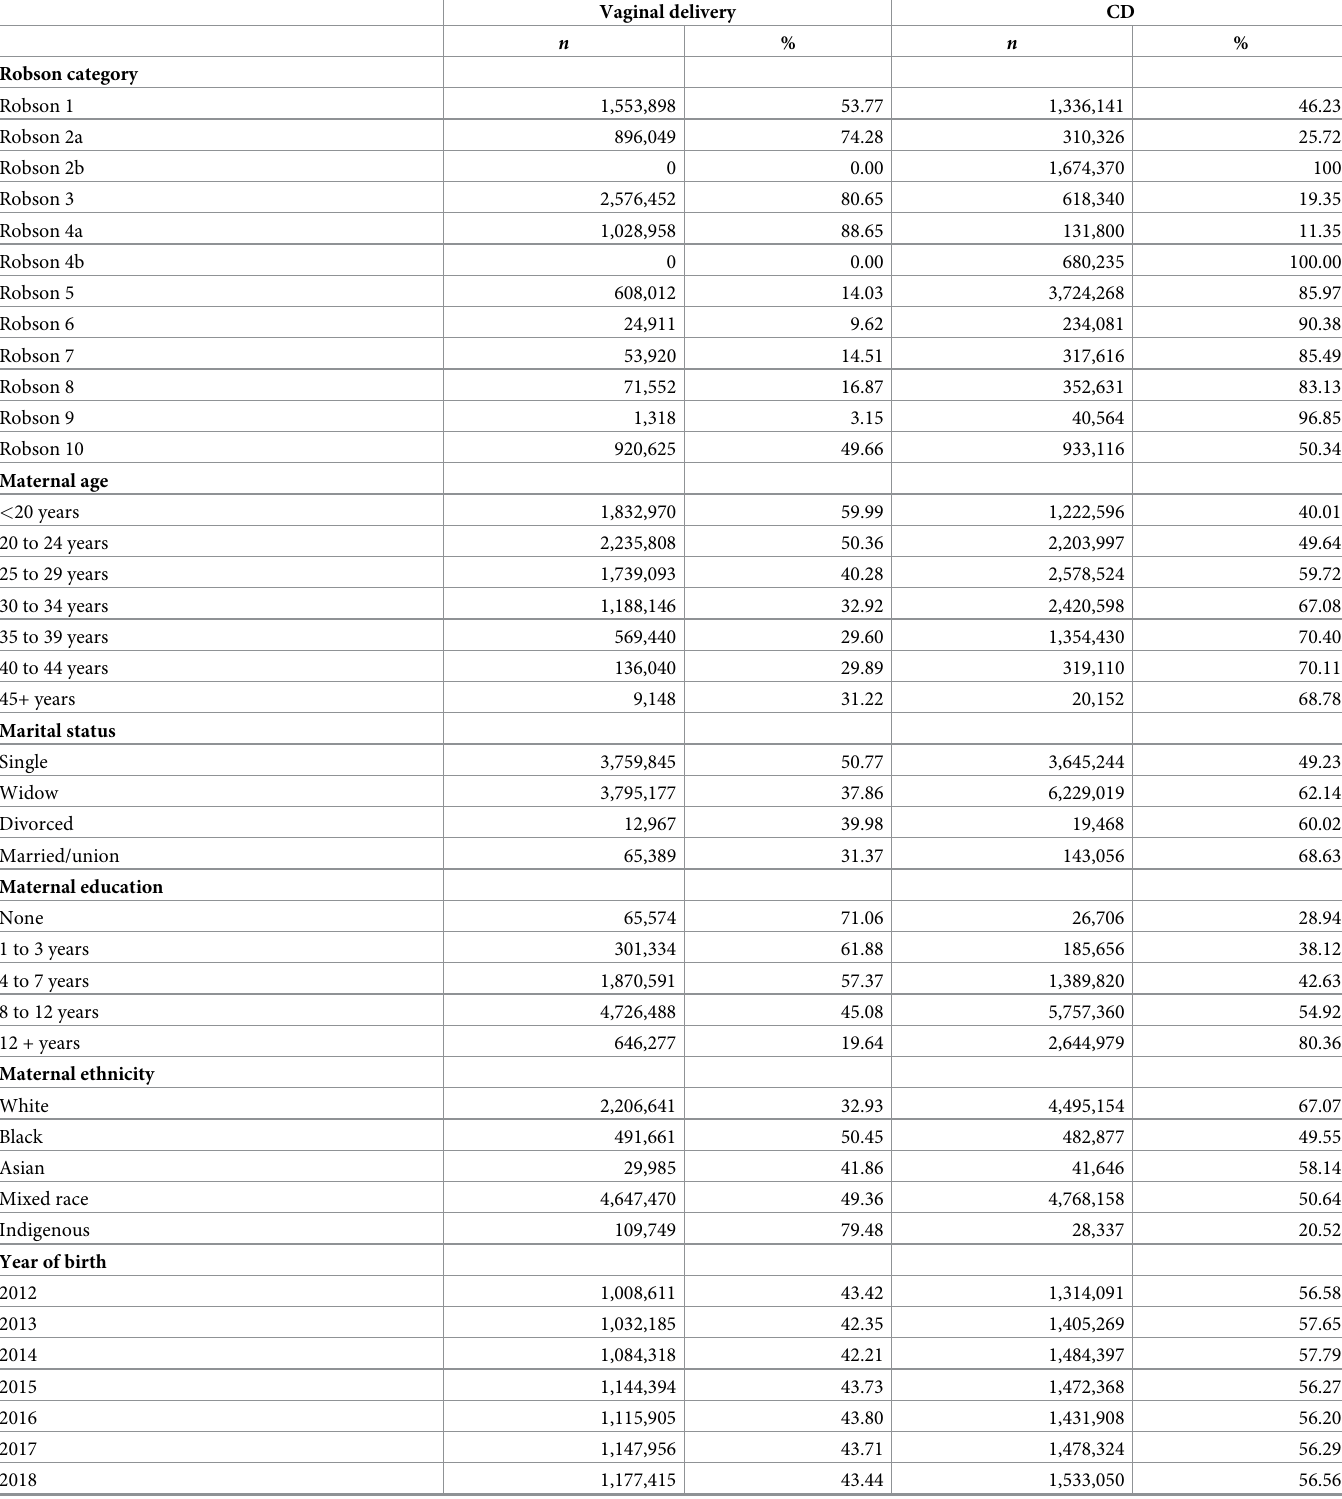
Table 1. Characteristics (number and percent) of 17,838,115 live births deliveries by mode of delivery in Brazil from 2012 to